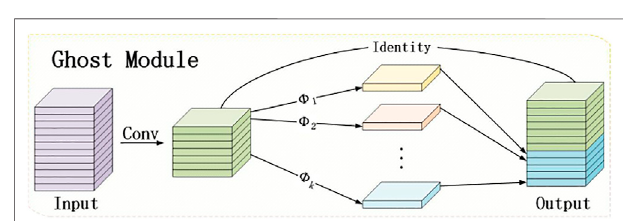
FIGURE 2 | Ghost module